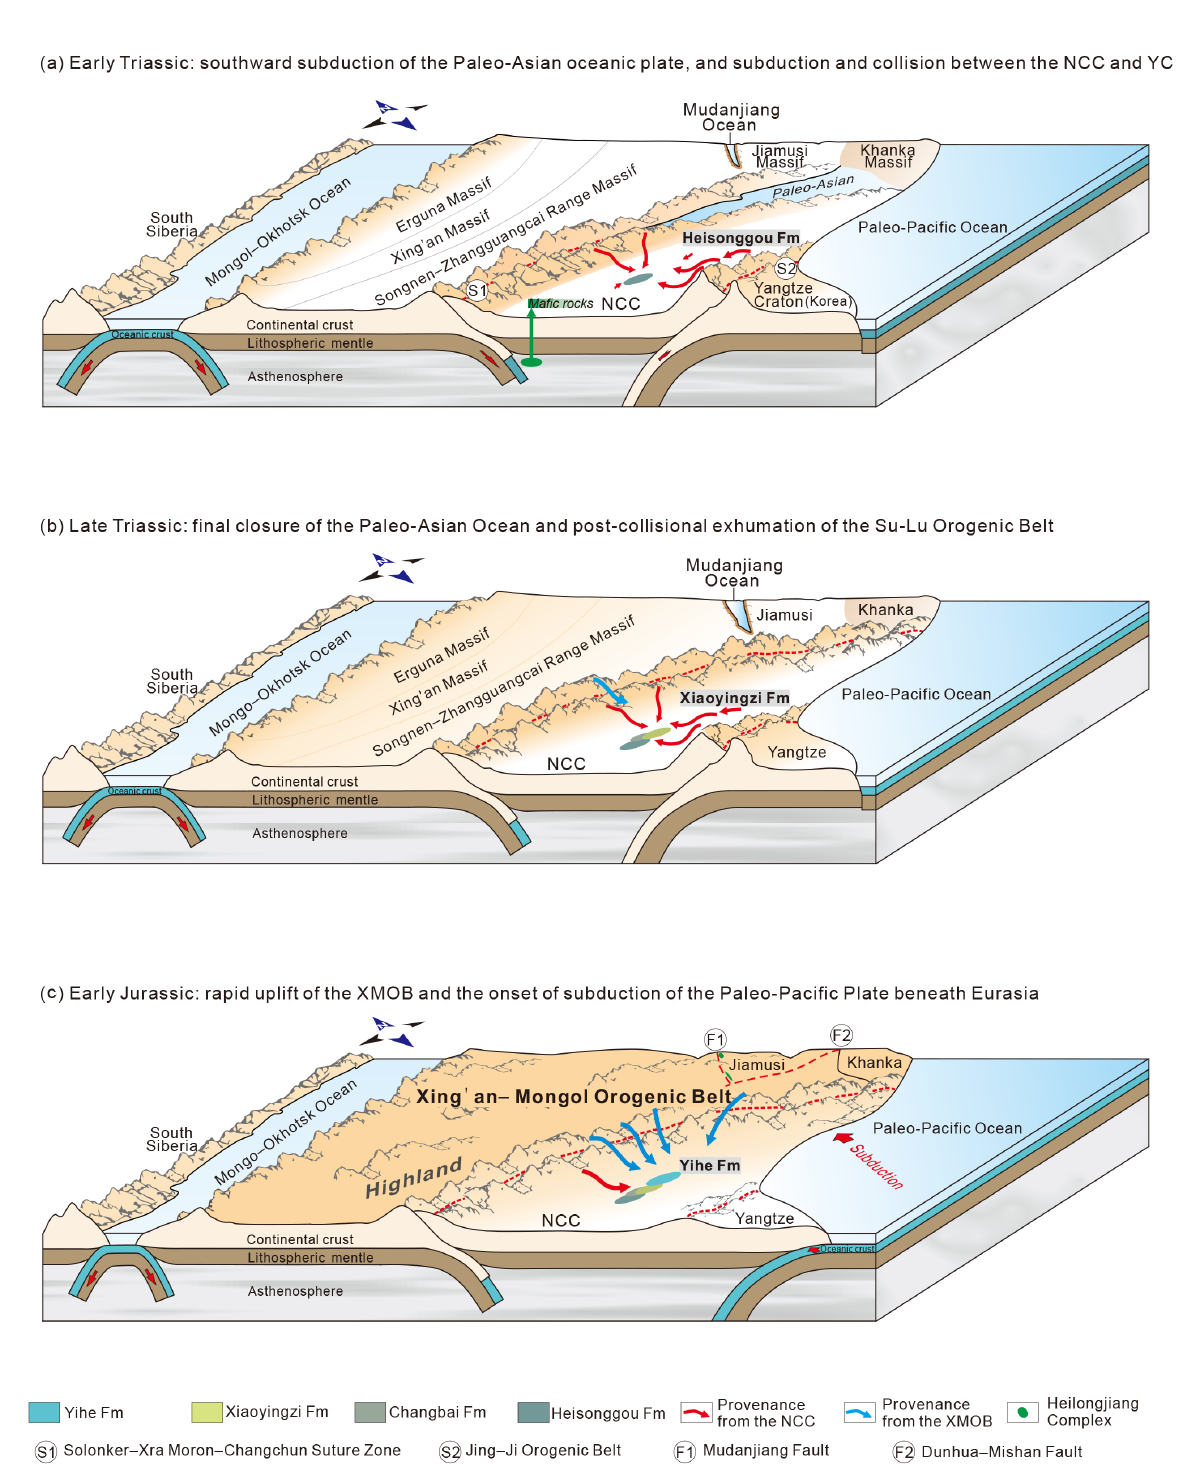
Figure 13. Paleotectonic evolution of northeastern China in the early Mesozoic, showing the paleogeographic evolution and provenance of early Mesozoic basins. (a) Early Triassic: southward subduction of the Paleo-Asian oceanic plate and subduction and collision between the NCC and YC; (b) Late Triassic: final closure of the Paleo-Asian Ocean and post-collisional exhumation of the Su–Lu Orogenic Belt; (c) Early Jurassic: rapid uplift of the XMOB and the onset of the subduction of the Paleo-Pacific Plate beneath Eurasia.